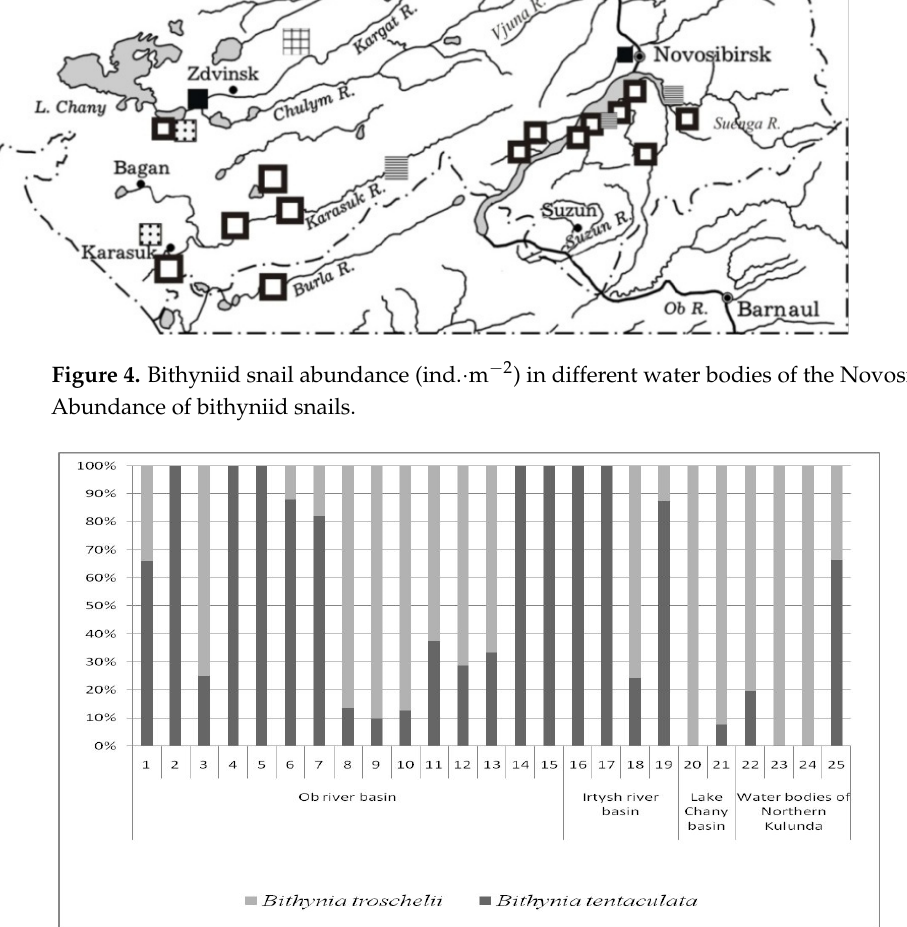
Figure 5. Mean density ratios of Bithynia troschelii to B. tentaculata in water bodies of the Novosibirsk region (average values for sites sampled more than once). Ob River basin: Ob River, downstream